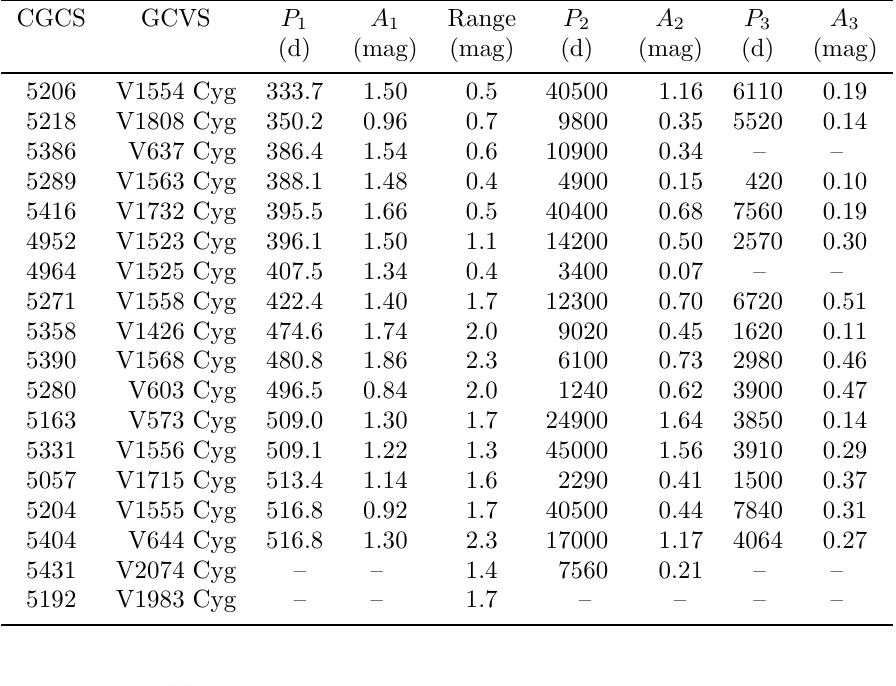
Table 1. Parameters of the light curves of the studied carbon stars.